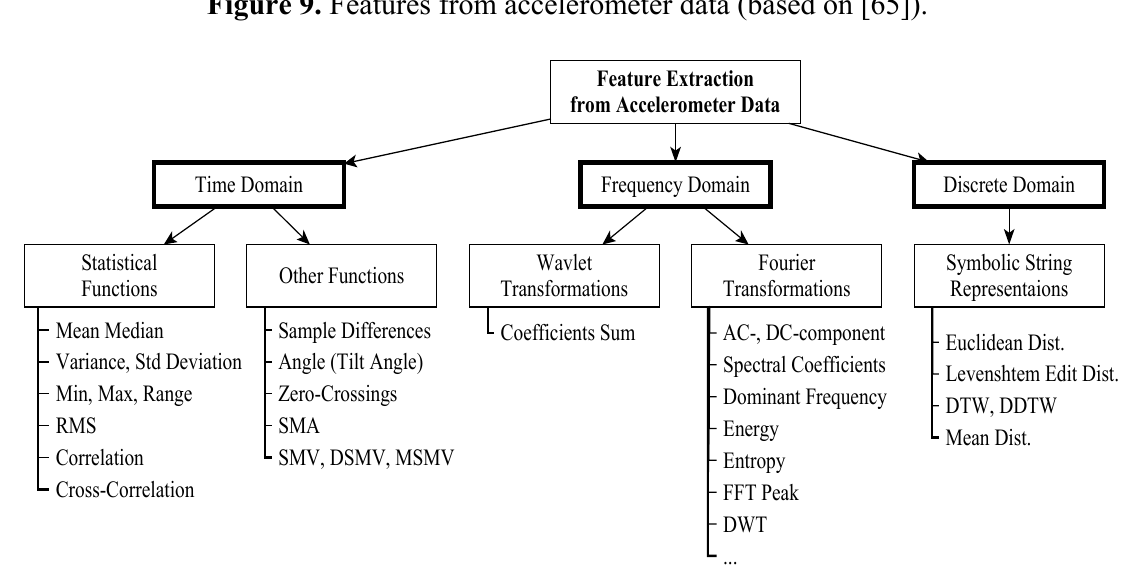
Figure 9. Features from accelerometer data (based on